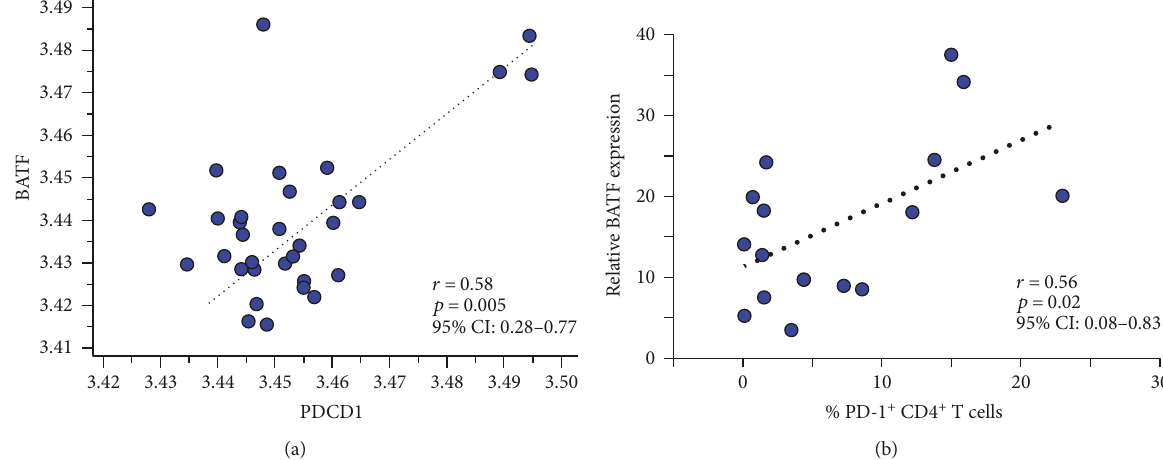
Figure 8: Positive correlation between BATF and PD-1 in sarcoidosis PBMC. (a) Correlation between log expression values of BATF and PDCD1 in sarcoidosis PBMC ( n = 32 ). BATF expression is positively correlated with PDCD1 expression in PBMC, indicating a statistically signi fi cant association between these two variables. (b) Correlation between quantitative RT-PCR values of BATF transcript and PD-1 expression in sarcoidosis CD4 + T cells ( n = 16 ). BATF expression is positively correlated with PD-1 expression in CD4 + T cells, indicating a statistically signi fi cant association between these two variables. Statistical analysis was performed using Student ’ s t -distribution for Pearson ’ s